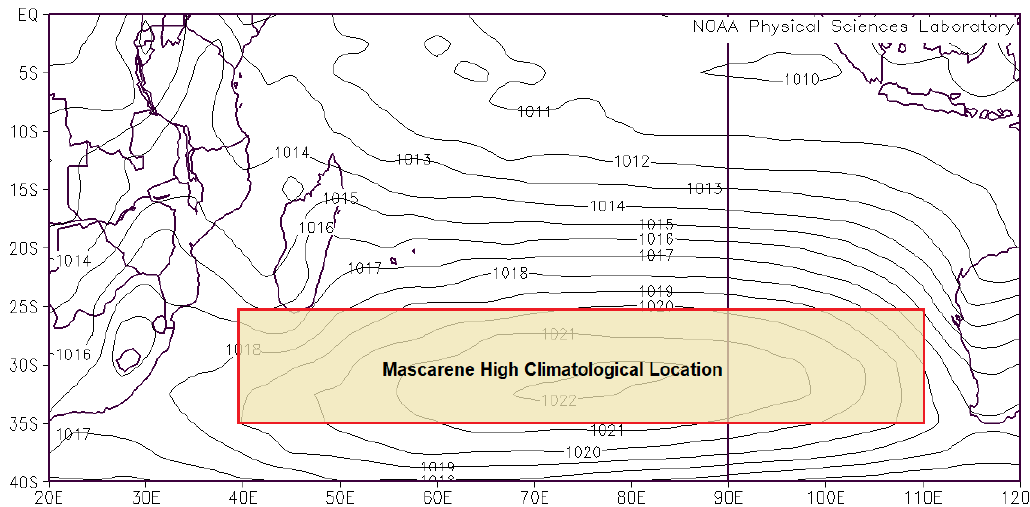
Figure 1. Mean Mascarene High regions over the South Indian Ocean (Generated from NOAA Physical Science Laboratory).